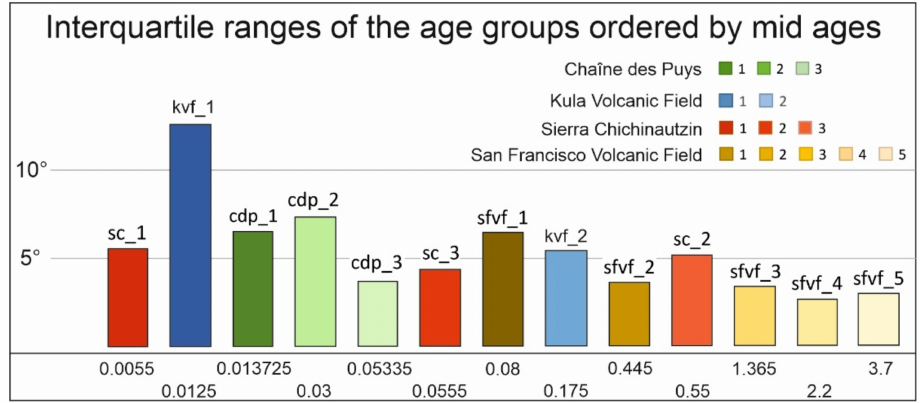
Figure 13. The interquartile ranges of the distributions of the age groups: reddish shades are Chichinautzin, greenish are Chaîne des Puys, bluish are Kula, and (brownish) yellowish are San Francisco age